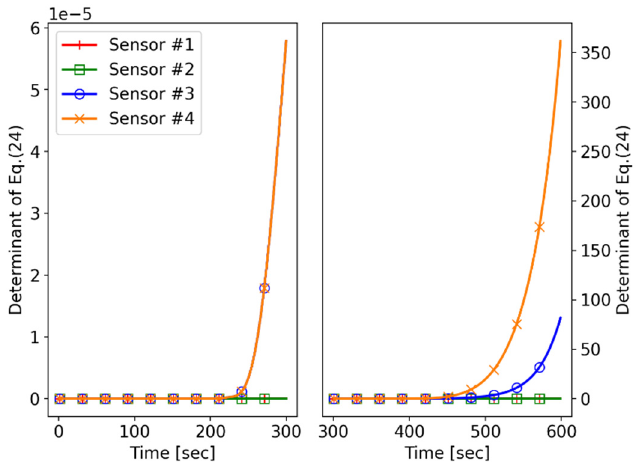
Figure 10. Simulation I: performance index.